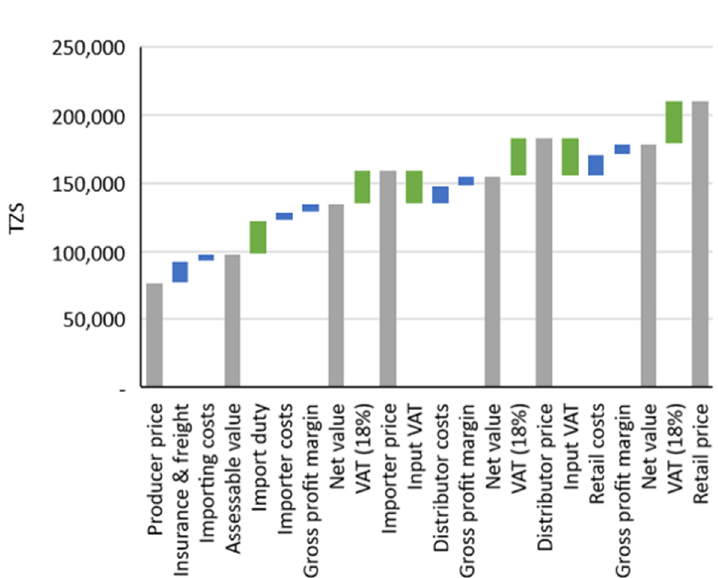
Figure 5. Waterfall plot of example EPC pricing structure.